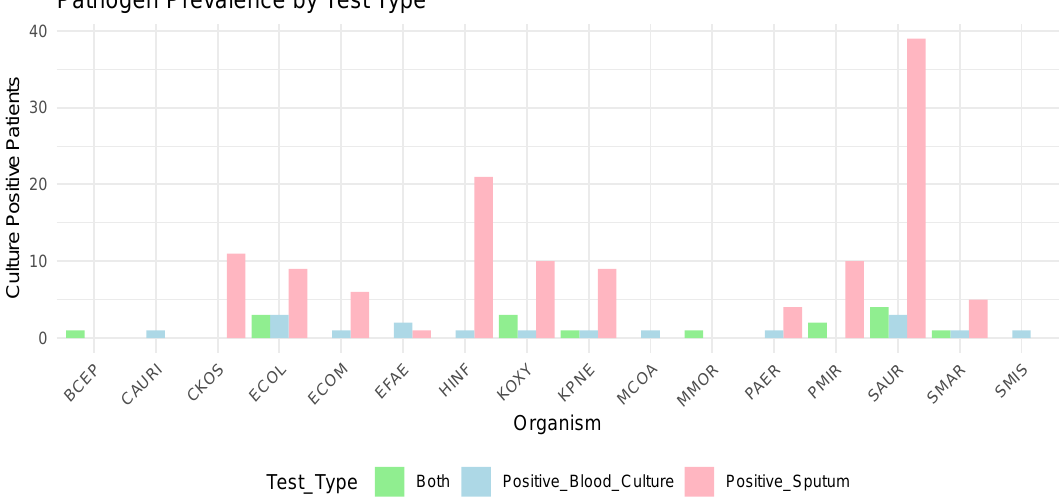
Figure 1. Prevalence of Pathogens Detected by Blood Cultures and Sputum Cultures (see Appendix A for Microbiology KEY).